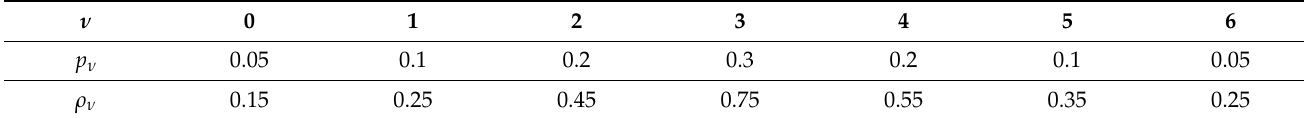
Table 9. The fuzzy random variable.